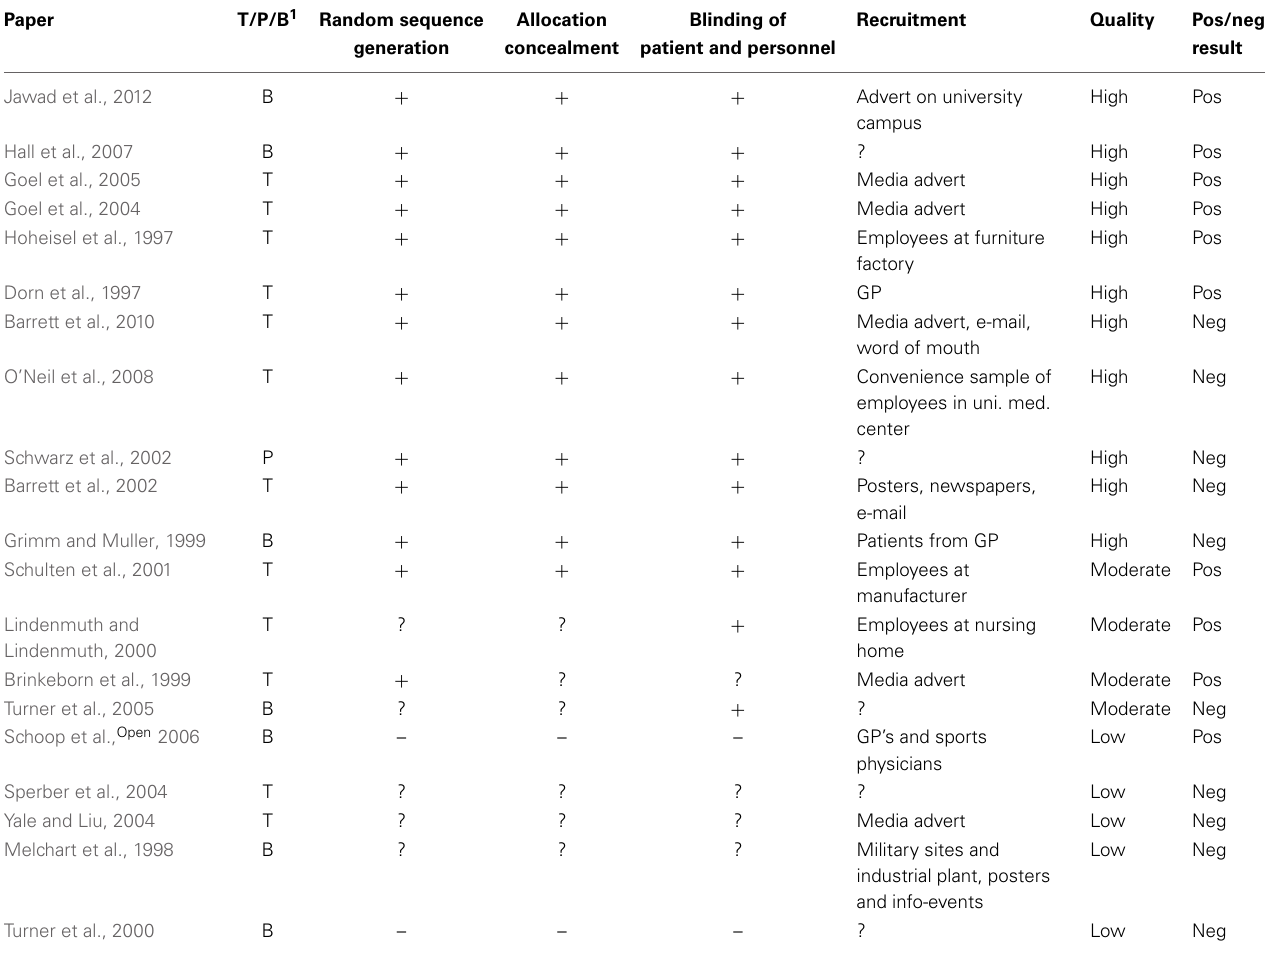
Table 3 | Quality of the studies of efficacy of Echinacea sp.